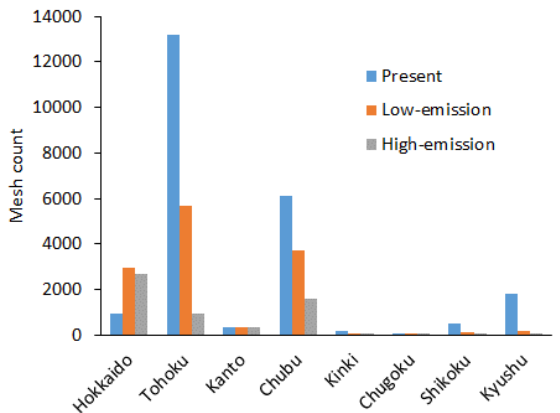
Figure 9. Predicted mesh counts suitable for growth of beech- dominated forests mesh for present and two future climate change